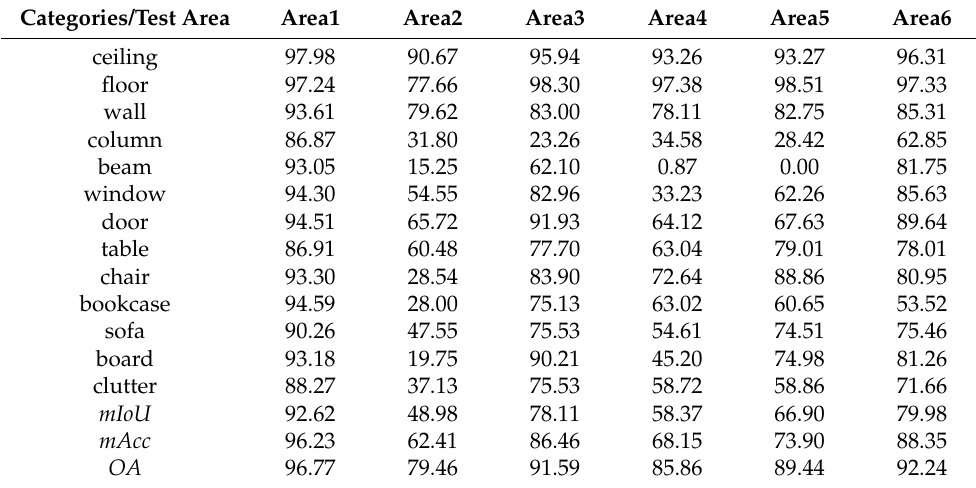
Table 1. The six-fold experiments on the S3DIS dataset (%).